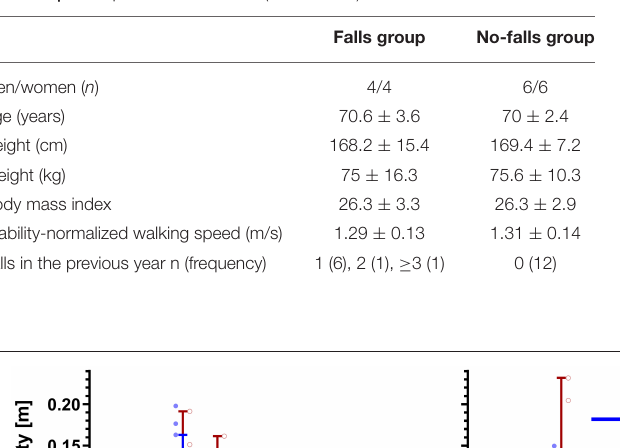
Frontiers in Sports and Active Living |